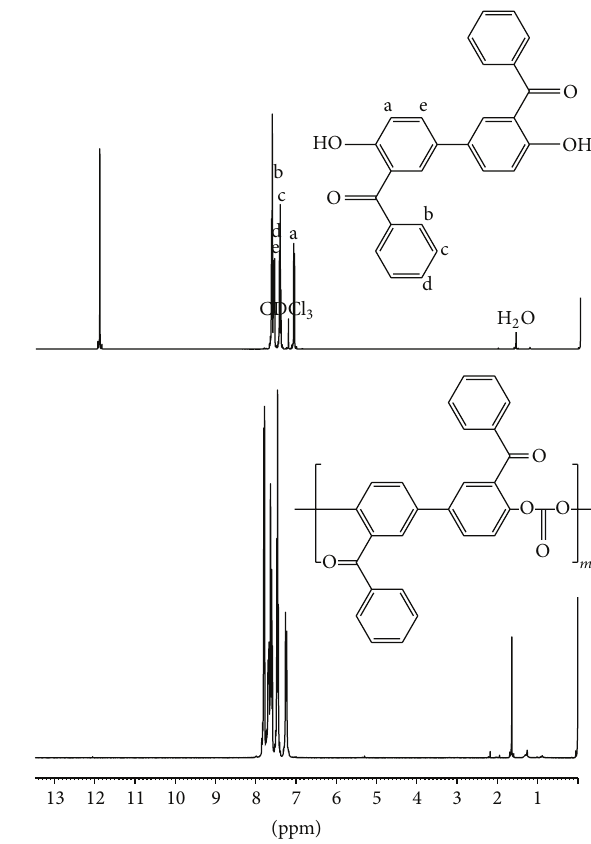
Figure 1: 1 H NMR of DBHP monomer and